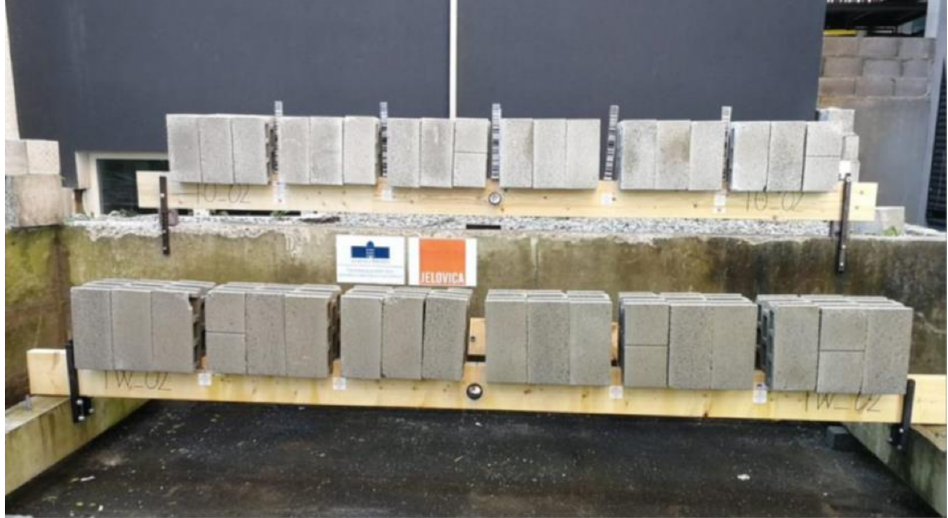
Figure 3. Setting up and loading of the two timber beams outside (TO and